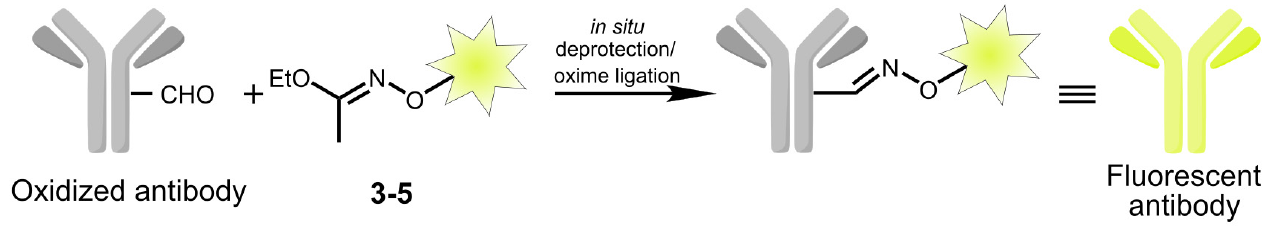
Figure 1. Antibody labeling scheme.